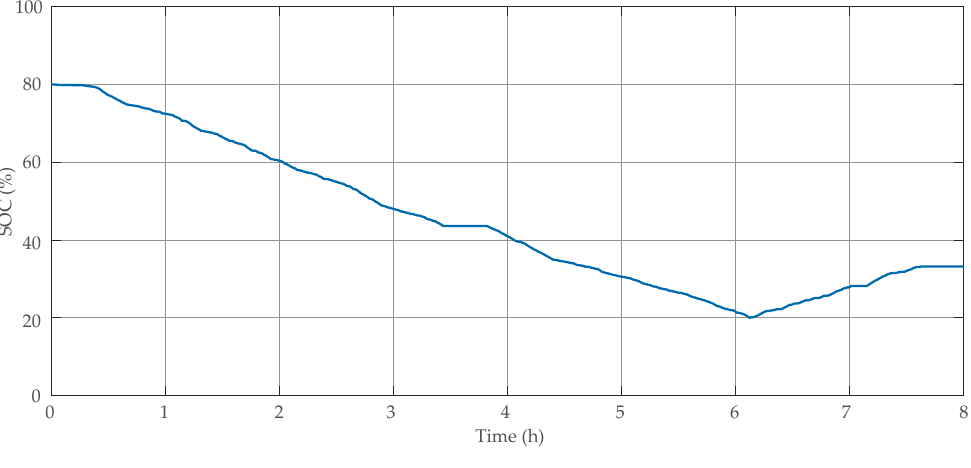
Figure 16. ESS state of